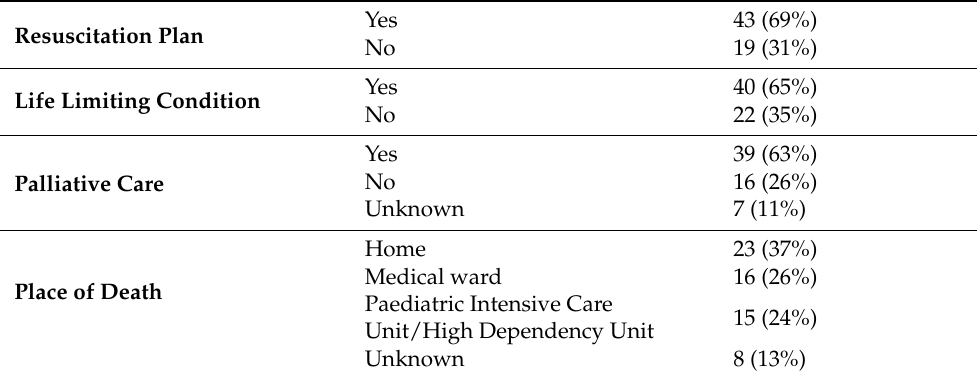
Table A1. Frequency of analysed variables (62